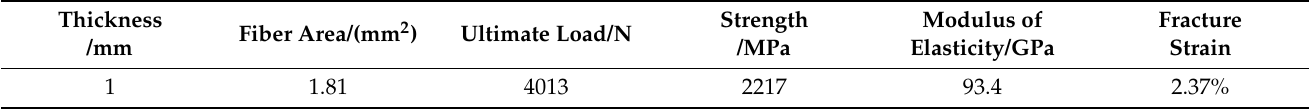
Figure 5. BFRP grid & mortar strengthened concrete arch structure. Table 2. Material properties of BFRP.